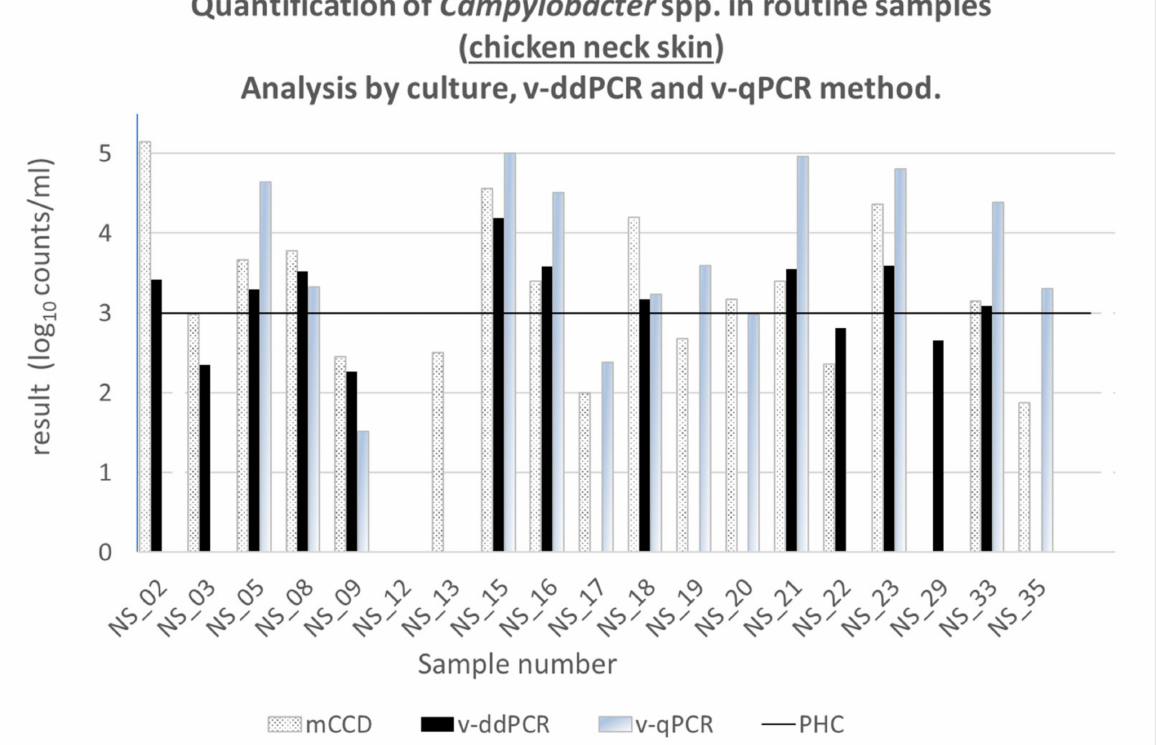
Figure 4. Analysis of LGL routine samples: chicken neck skin (NS) from slaughterhouse. Analysis in culture, v-ddPCR, and v-qPCR. The Process Hygiene Criterion (PHC: log 10 3.0) is marked with a black